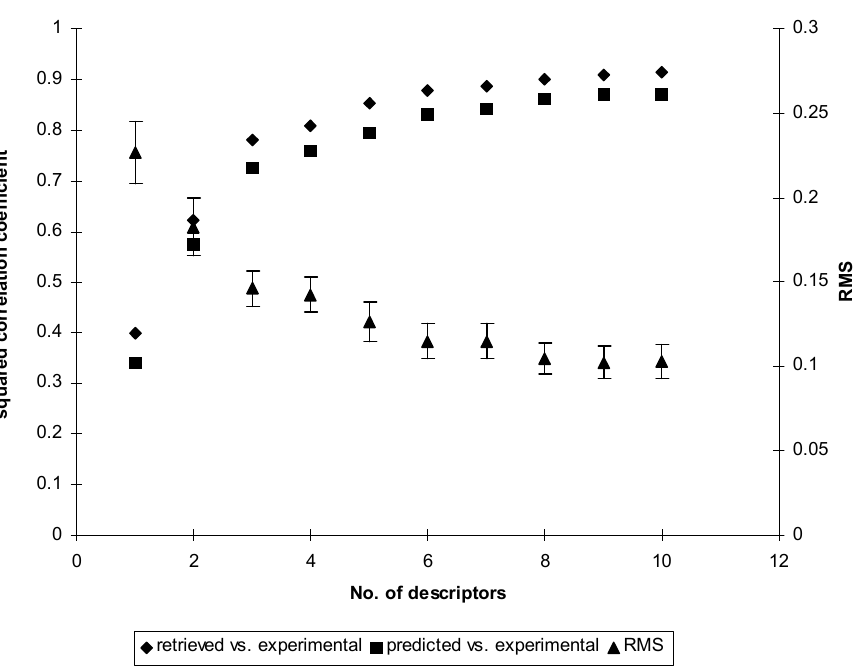
retrieved vs. experimental predicted vs. experimental